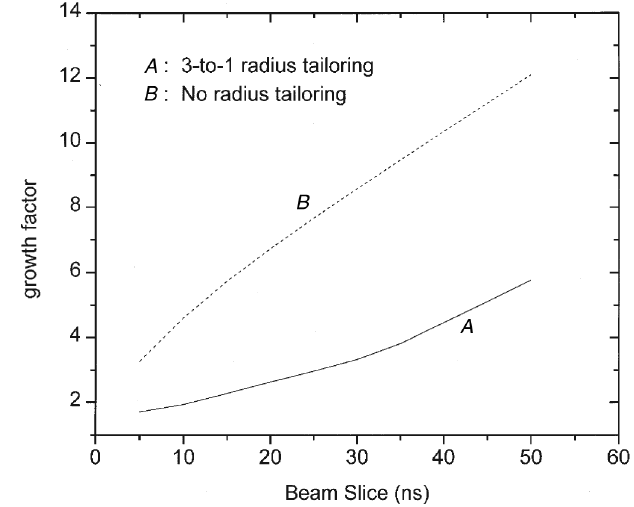
FIG. 5. Instability growth for a 300-MeV, 2-kA, 2-cm radius proton beam using the time-dependent channel conductivity model of Eqs. (27) and (28).